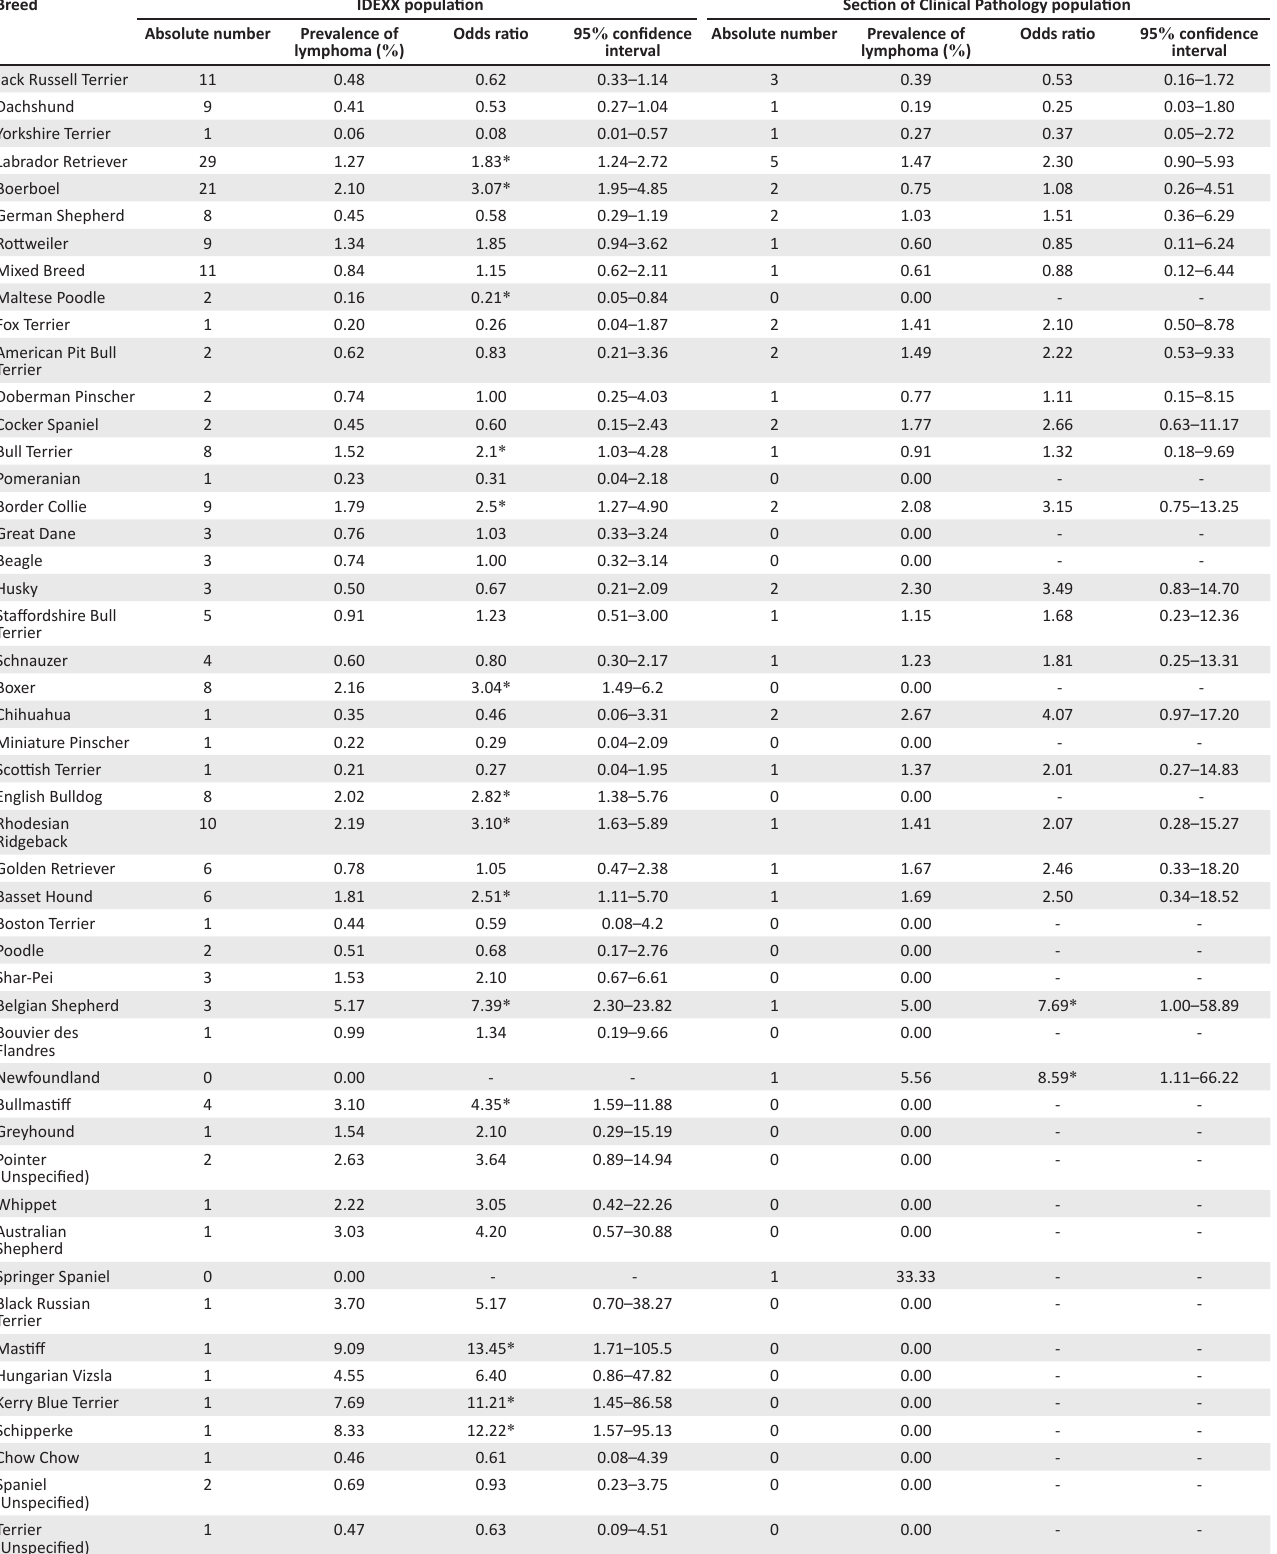
TABLE 2: Prevalence, odds ratios and their confidence intervals for lymphoma in 49 dog breeds from two study populations.